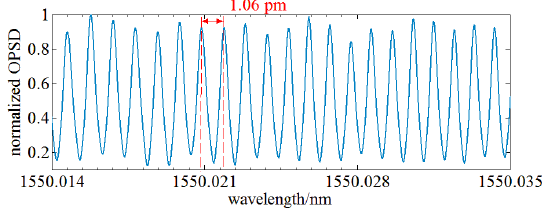
Figure 13. Optical spectrum of a fiber MZI sensor measured by the OENF system.